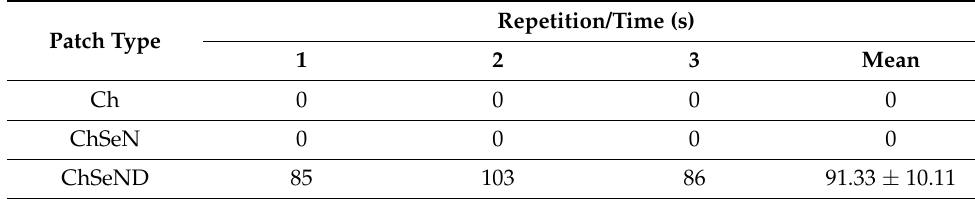
Table 3. Adhesion strength of different patches.